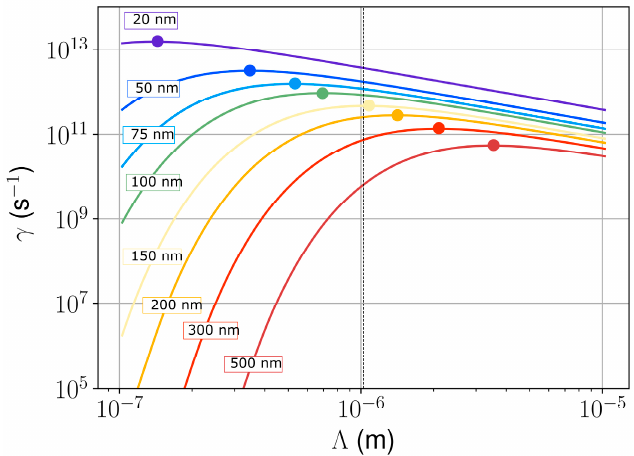
Figure 8. Growth rate, γ , of the thermo-convective instability as a function of the period of the unstable mode at T = 2000 K. Dots identify the most unstable mode for thin layers of hot fused silica, varying the thickness, h , from 20 to 500 nm.